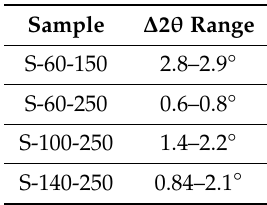
Table 1. Expected for (200) / (002) peak